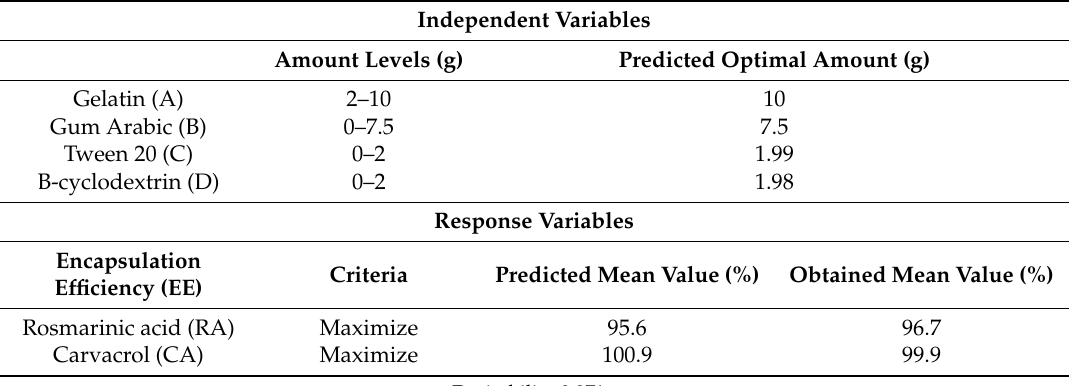
Table 3. Numerical optimization of wall material amounts using desirability